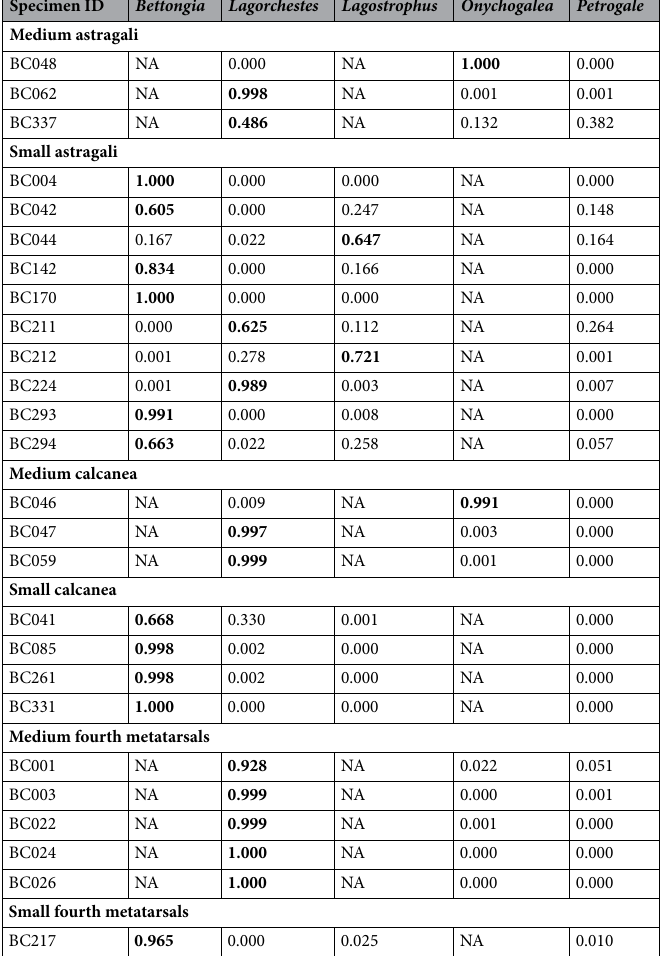
Table 2. Classification matrix for specimens from Boodie Cave. Highest posterior probability for each specimen indicated in bold.